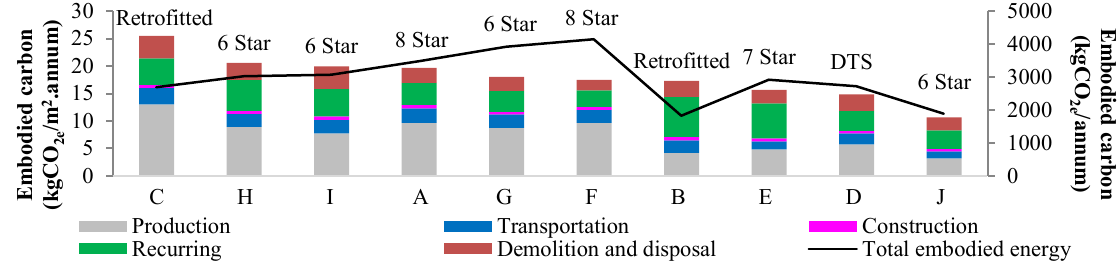
Fig. 3. Yearly embodied carbon per square meter categorised into the fi ve building life cycle stages and total yearly embodied energy for